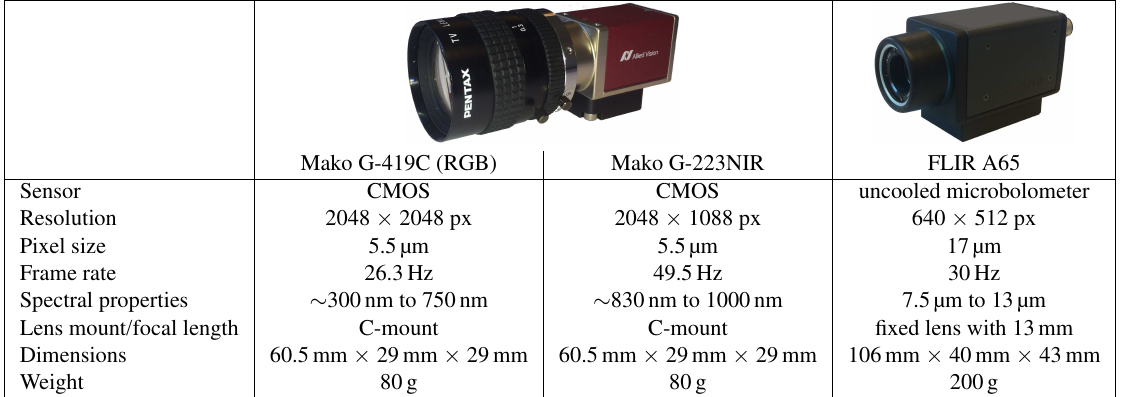
Table 1: Sensors of multispectral camera bar mounted on UAV # 3